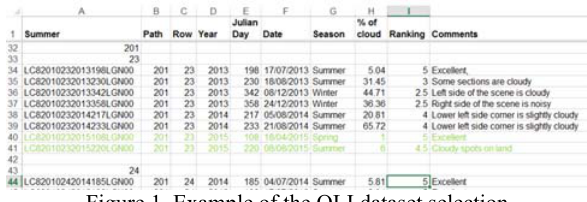
Figure 1. Example of the OLI dataset selection